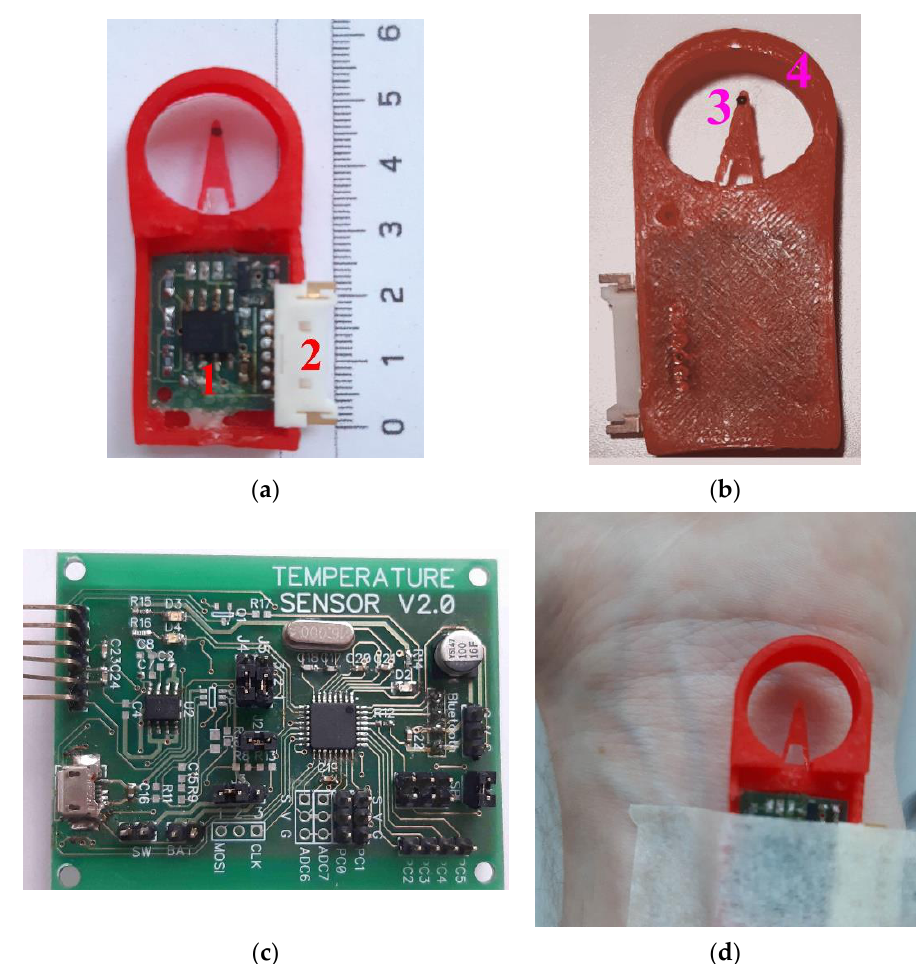
Figure 8. Appearance of the original construction of high-sensitive device for measurement body surface temperature oscillations: measuring part top view ( a ), 1—pre-amplifier board with control of the operating point of the first amplifying stage and the gain of the second amplifying stage, 2—connector; measuring part bottom view ( b ), 3—temperature sensor—silicon chip transistor (D1), 4—“protective ring”; processing unit top view ( c ); fixing the sensor with medical plaster in the region of the wrist joint of the right hand ( d ).